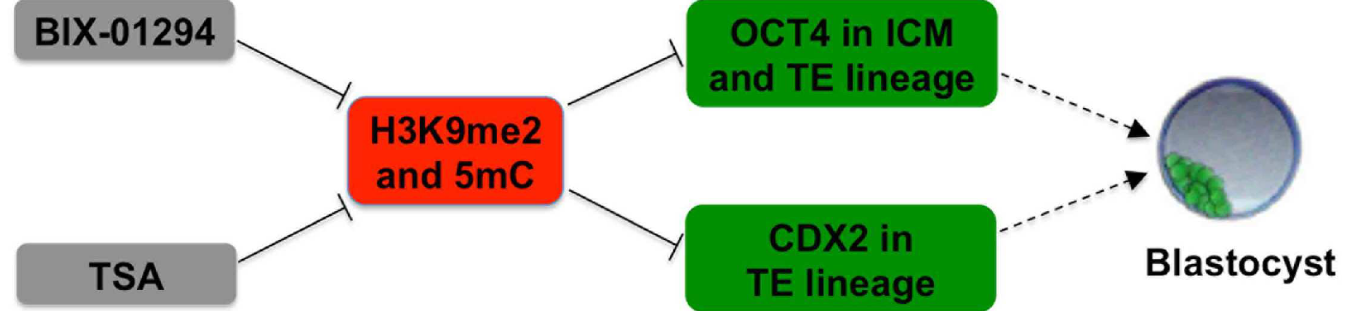
Fig 6. Model for the potential mechanisms of TSA and BIX-01294-induced the enhanced developmental efficiency of SCNT embryos. Histone deacetylasesand methyltransferase inhibitor(TSA and BIX-01294) synergistically reduce the expressionlevels of H3K9me2 and 5mC in SCNT 4-cell and blastocysts which could indirectly promote the increasedexpressionof OCT4 and CDX2 important for both inner cell mass (ICM) and trophectoderm (TE) lineagedifferentiation. Based on these data, we proposethat TSA and BIX-01294enhanceblastocyst formation rate of porcine SCNT embryospotentially through facilitating the increasedexpressionof OCT4 and CDX2 involvedin the differentiationof ICM and TE lineage.Solid and dash lines indicate the proven and putative results in the present study,